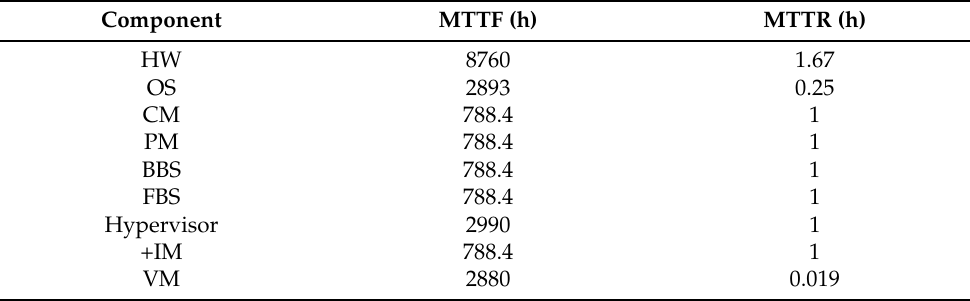
Table 5. Values used in the RBD analysis.